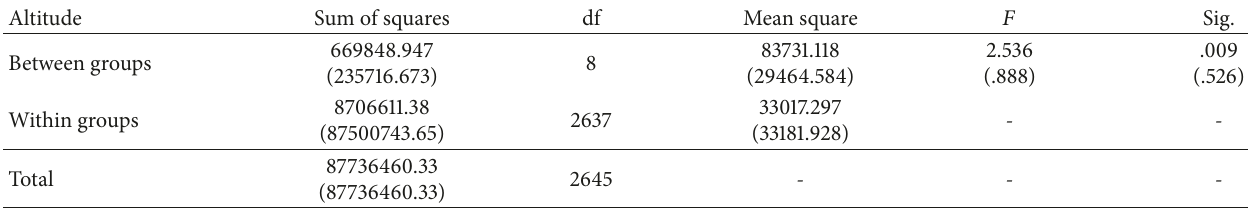
Table 3: Influence of altitude on severe drought (wet) frequencies for JFM subseason. Altitude Sum of squares df Mean square Sig. Between groups Within